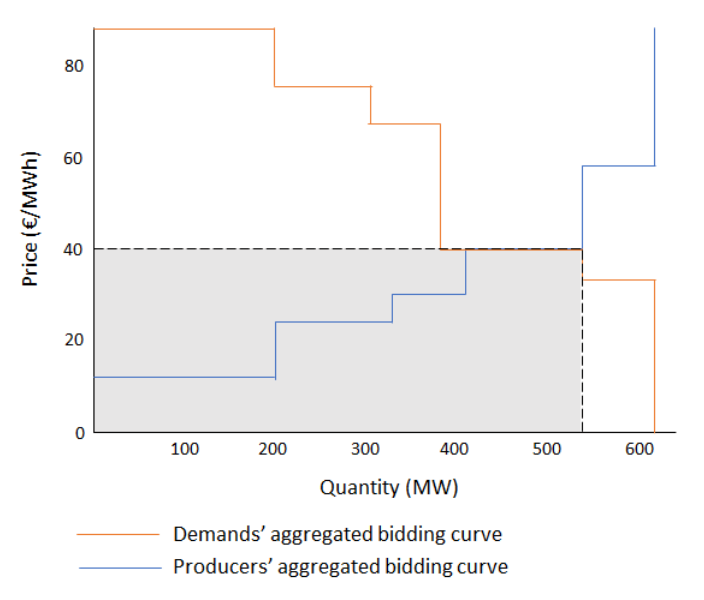
Figure 1. Uniform price auction clearing